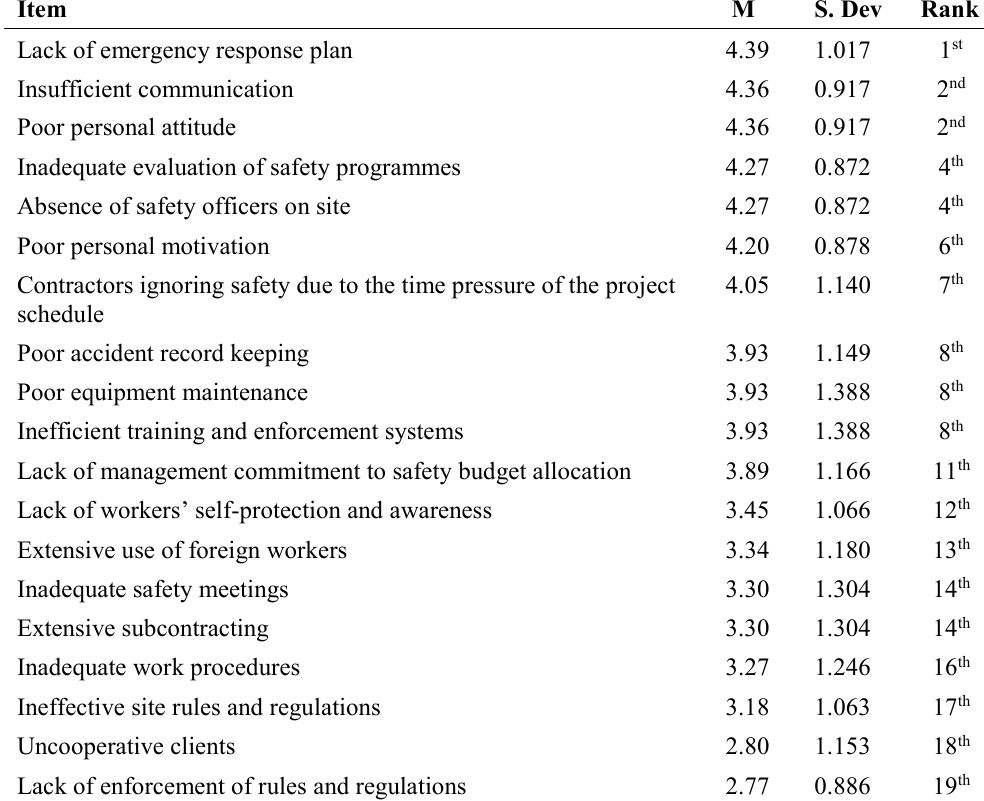
Table 3. Factors Affecting the Implementation of Health and Safety